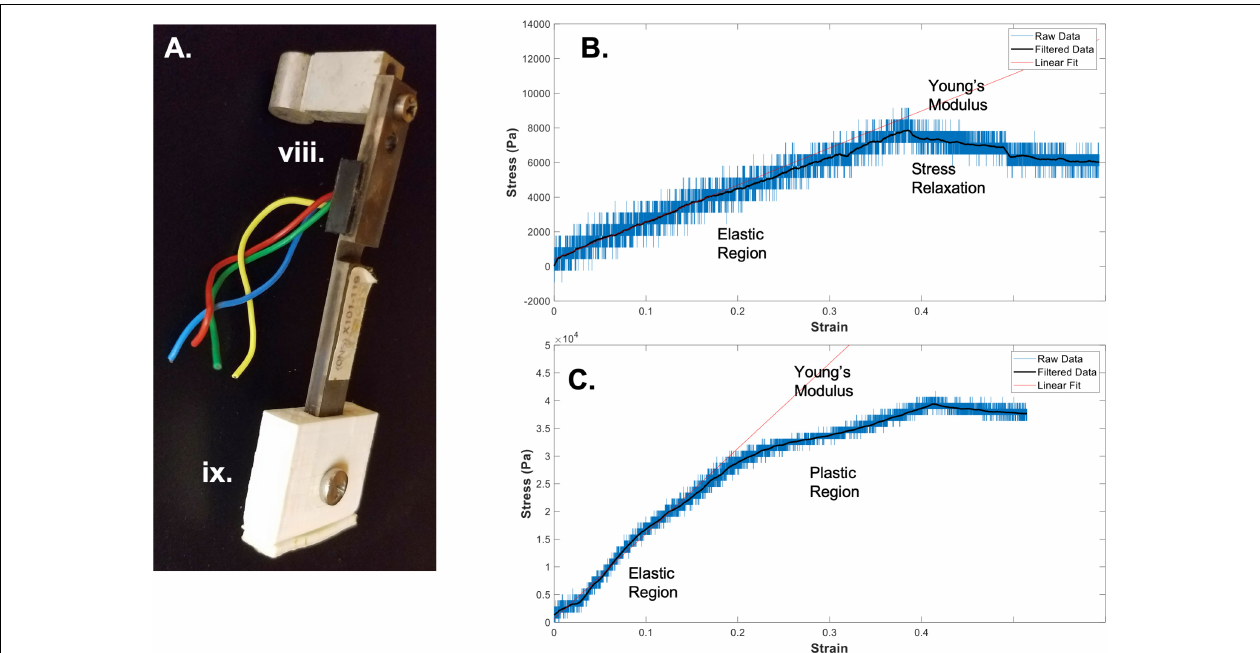
FIGURE 2 | Bioreactor for mechanical testing. (A) Image of a force sensor, used as one end of the sample clamping, that allows for measurement of stresses during strain application to the sample. (B) A sample stress-strain curve from an electrospun fibrin microfiber measured with the bioreactor (Gilbert-Honick et al., 2020). (C) A sample stress-strain curve from an electrospun fibrin microfiber crosslinked with EDC/NHS chemistry as previously described (Gilbert-Honick et al., 2020). In both (B,C) strain was stopped at approximately 40% while measurement of force continued. Black line indicates filtered data. Roman numerals refer to the list